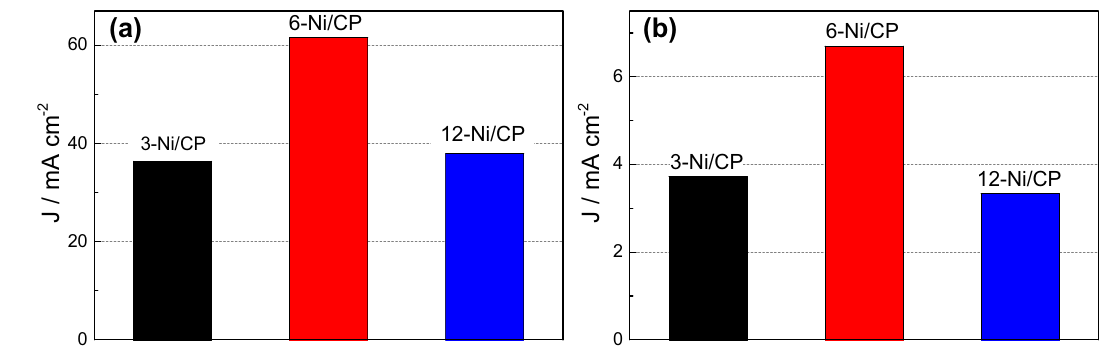
Fig. 10 a Peak current density from urea electrooxidation (from CV experiments), and b current density from CA at 60 min of